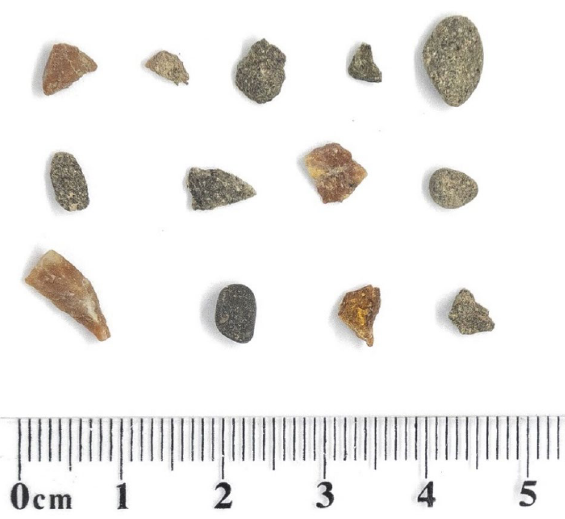
Figure 1. Photographs of pebbles Bruce manipulated and preened with which could be retrieved by the experimenters. Tools were retrieved by the experimenters only after Bruce dropped